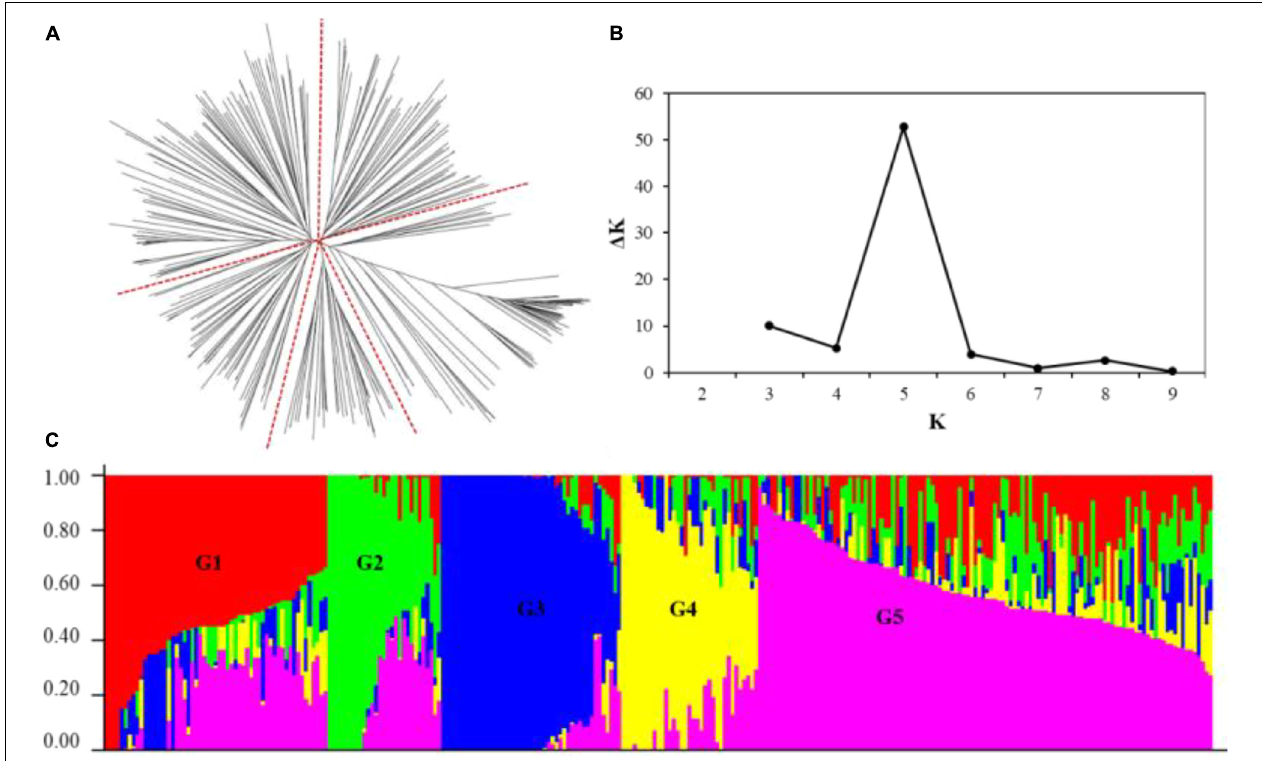
FIGURE 2 | Population structure of the 282 wheat accessions using 9,793 single nucleotide polymorphism (SNP) markers across the whole genome. (A) Neighbor-joining tree of the 282 accessions; (B) a number of subpopulations estimated by (cid:49) K at a range of K values; and (C) population structure inference of the 282 wheat genotypes based on the SNP marker, using STRUCTURE version